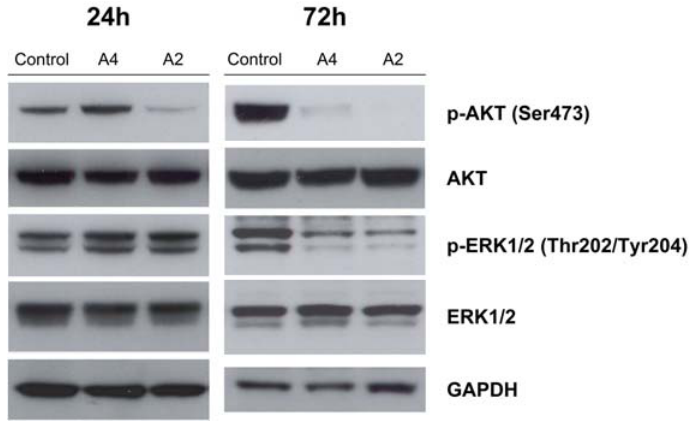
Figure 4. Intracellular signaling events induced by compounds A2 and A4 in vitro . PC-3 human prostate cancer cells were treated with 10 μ M of compounds A2 and A4 for 24 and 72h. Cells were lysed for Western Blot analysis using antibodies specific to p-AKT, AKT, p-ERK, ERK and